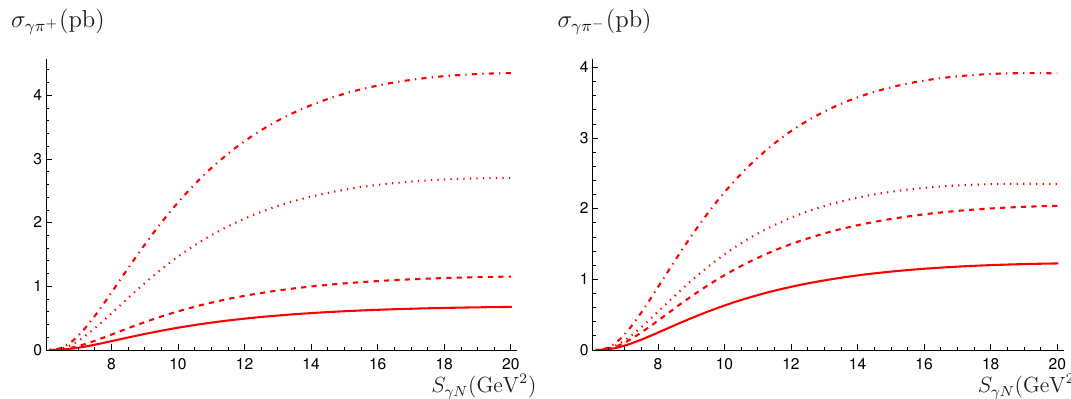
Figure 35 . The integrated cross-section for π + ( π − ) is shown as a function of S γN on the left (right). The dashed (non-dashed) lines correspond to holographic (asymptotic) DA, while the dotted (non-dotted) lines correspond to the standard (valence) scenario.